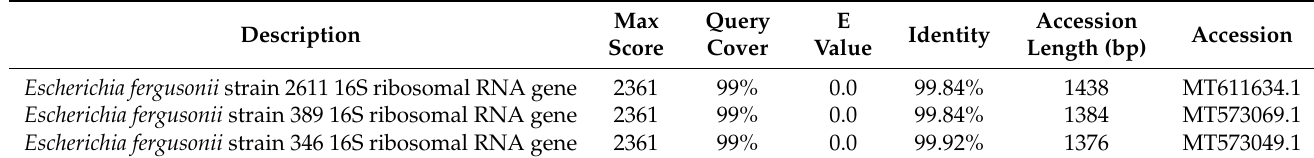
Table 2. BLASTN result of partial 16s rRNA gene sequence of TB1. The description below is only of the three closest strains in NCBI.